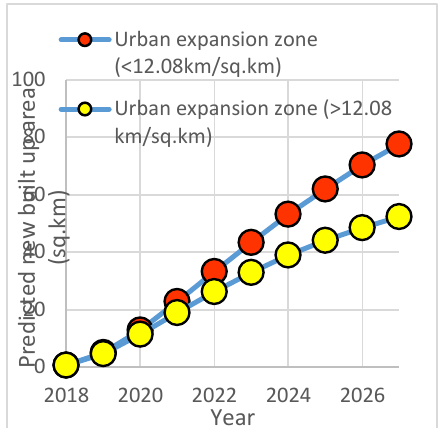
Figure 10. Predicted urban growth categorized and quantified w.r.t. road density turning point